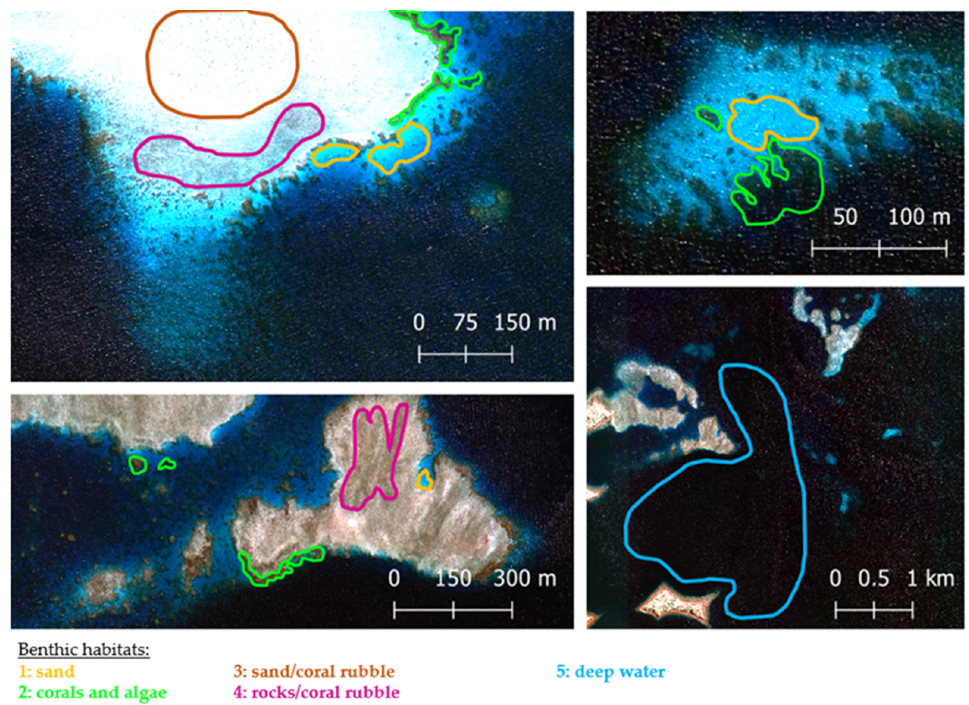
Figure 5. Maps of the five benthic habitats identified on the 0.5 m Pleiades-1A TOA reflectance imagery.